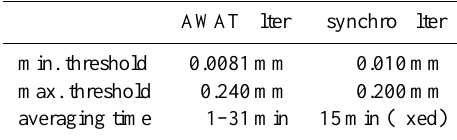
Table 2. Parameters used for the adaptive